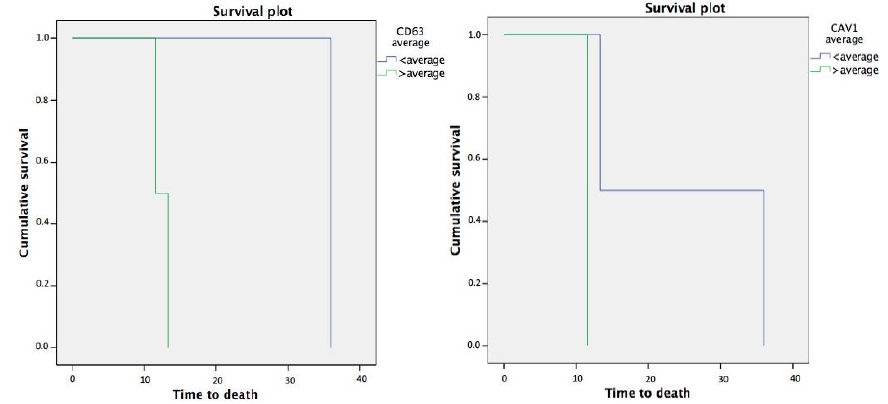
Figure 3. The graph shows the cumulative survival of patients according to their average levels of exosomes with CD-63 (left) and CAV-1 (right) before resective surgery. Thus, patients with exosomes CD63+ (CD63+ EXO (Exosome)) amounts lower than the mean